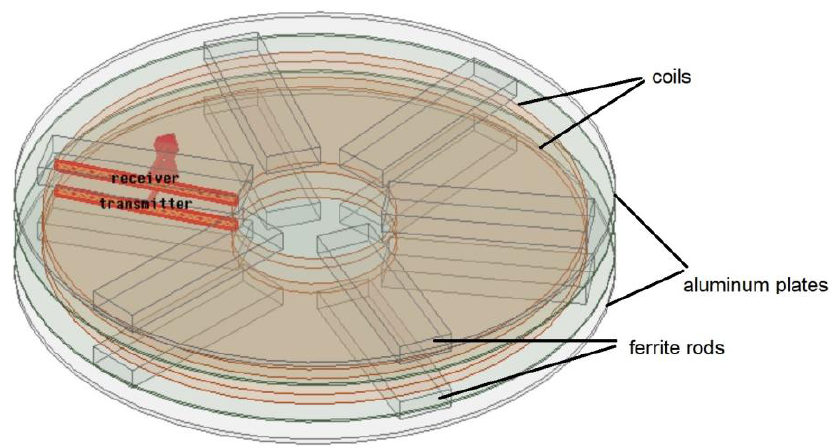
Figure 5. IPT coil model.